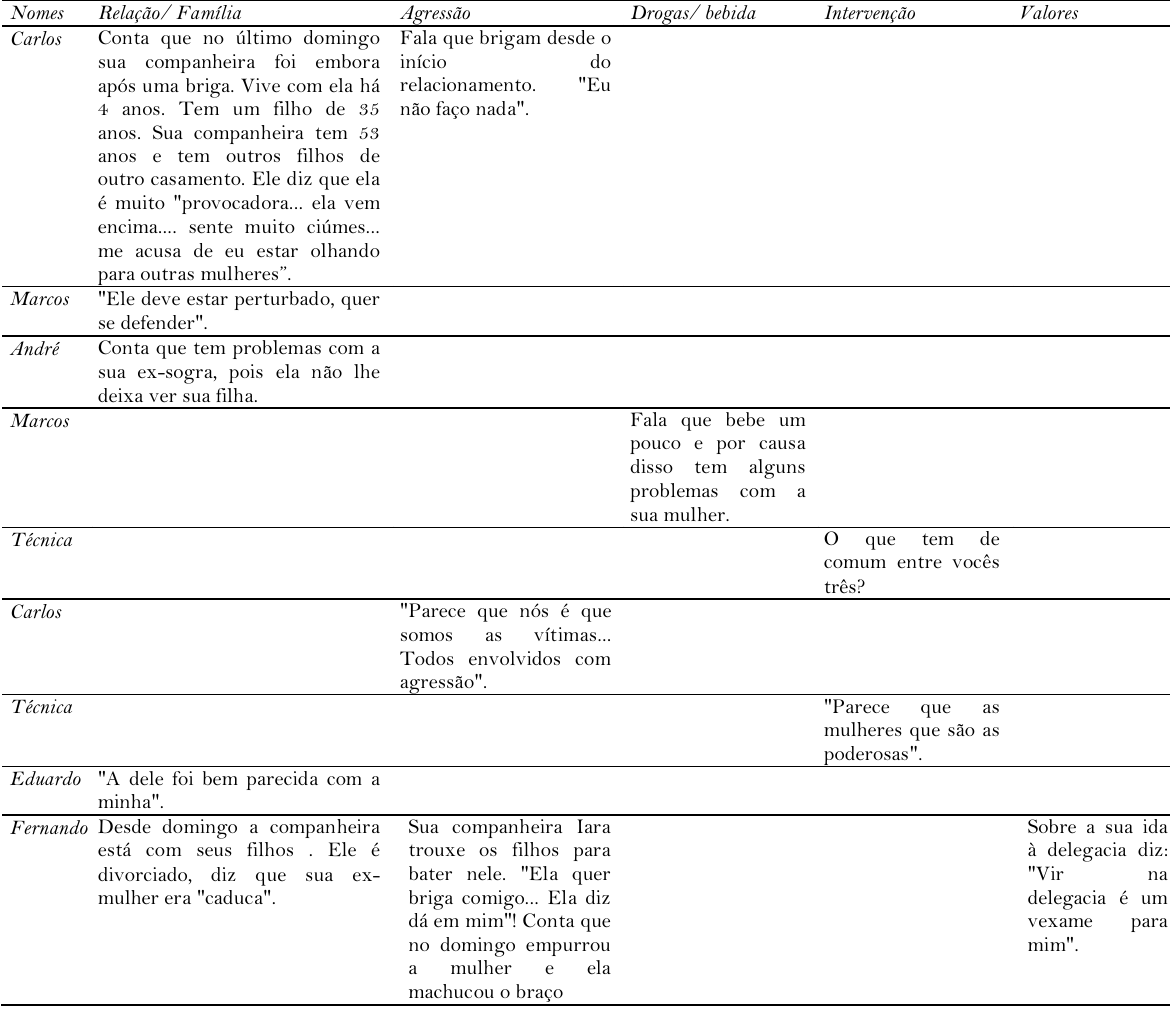
Tabela 1 Produção de Sentidos Nomes